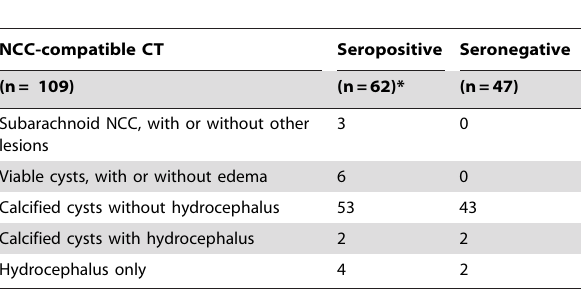
Table 3. NCC-compatible CT findings in seronegative and seropositive individuals with epilepsy in Tumbes,